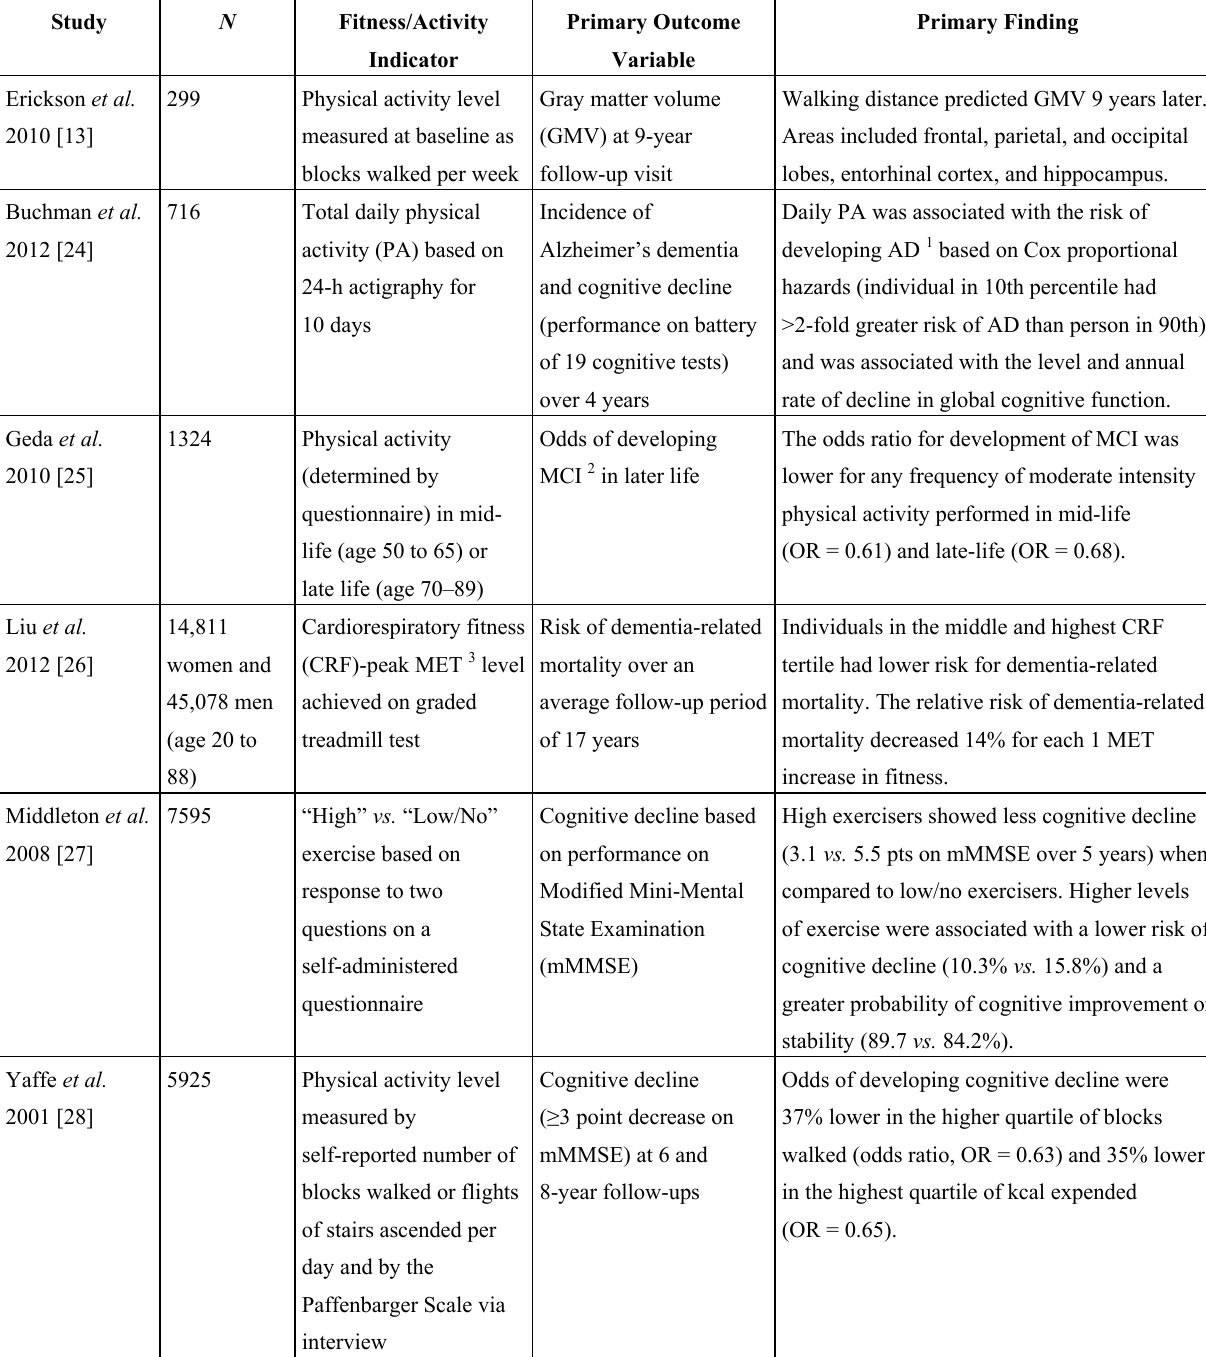
Table 1. Summary of cross-sectional and observational studies regarding physical activity, fitness, and brain